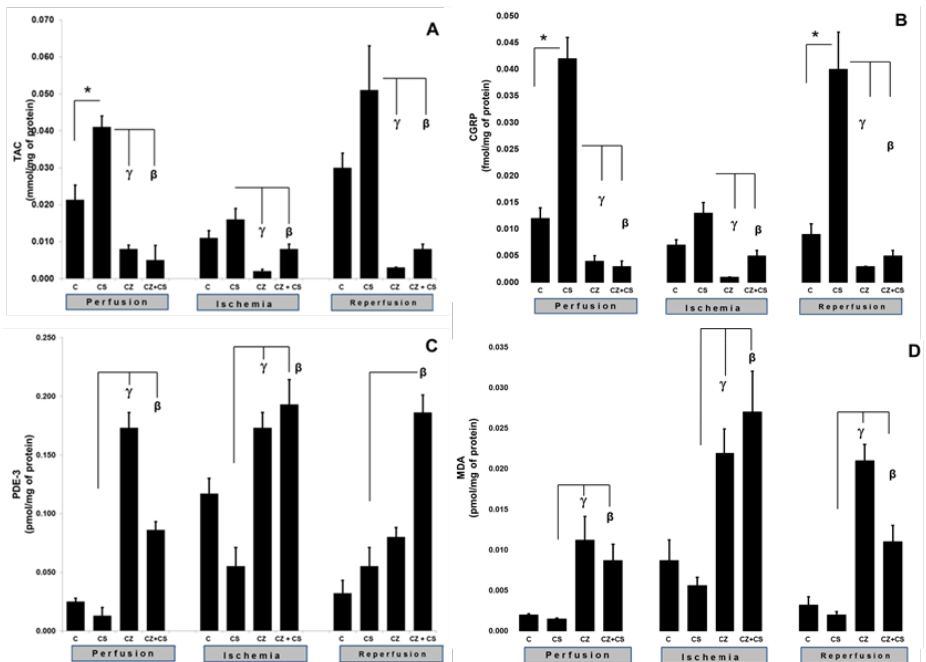
Figure 4. Cardiac TAC levels as an indicator of modifications in oxidative stress ( A ) and CGRP levels as an indicator of TRPV1 activation ( B ). Levels of tissue damage indicators PDE-3 ( C ) and MDA ( D ). The determinations of these biomarkers were made in ventricular tissue of isolated hearts perfused in three conditions: perfusion (30 min), ischemia (30 min) and reperfusion (60 min). Hearts were obtained from control rats and treated with CS, CZ and CZ+CS. Ventricular tissue samples were obtained at the end of reperfusion. Values are the mean ± SE ( n = 5 in each group p ≤ 0.05).* C vs. CS; γ CS vs. CZ; β CS vs. CZ+CS.